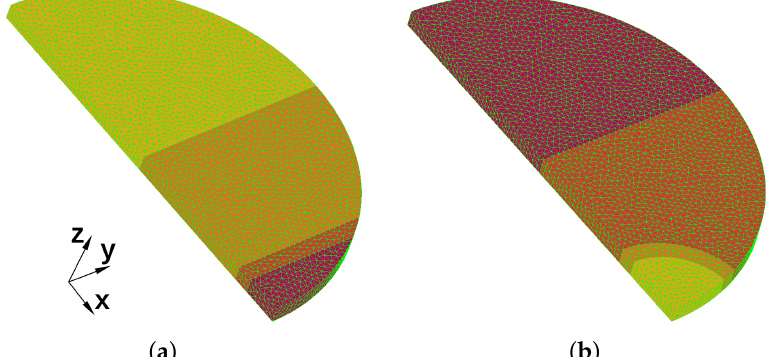
Figure 3. Finite element mesh corresponding to the symmetric halves of the resonators, ( a ) in the shape of circular segment, ( b ) in the shape of an intersection of